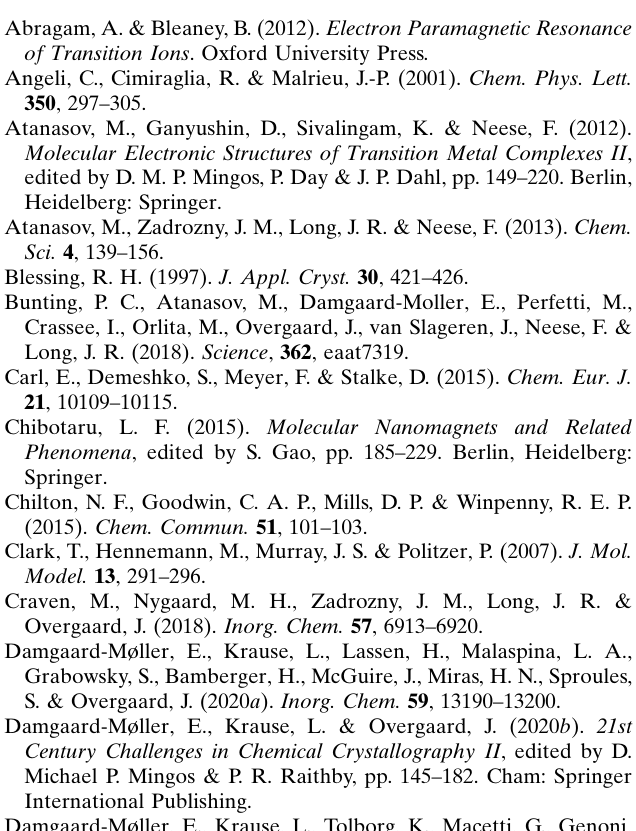
Figgis, B. N., Forsyth, J. B. & Reynolds, P. A. (1987). Inorg. Chem. 26 , 101–105. Figgis, B. N. & Hitchman, M. A. (2000). Ligand Field Theory and its Applications. New York: Wiley-VCH. Figgis, B. N., Reynolds, P. A. & Forsyth, J. B. (1988). J. Chem. Soc. Dalton Trans. 640 , 117–122. Figgis, B. N., Reynolds, P. A. & Mason, R. (1982). Proc. R. Soc. London Ser. A , 384 , 49–55. Figgis, B. N., Reynolds, P. A. & Mason, R. (1983). J. Am. Chem.